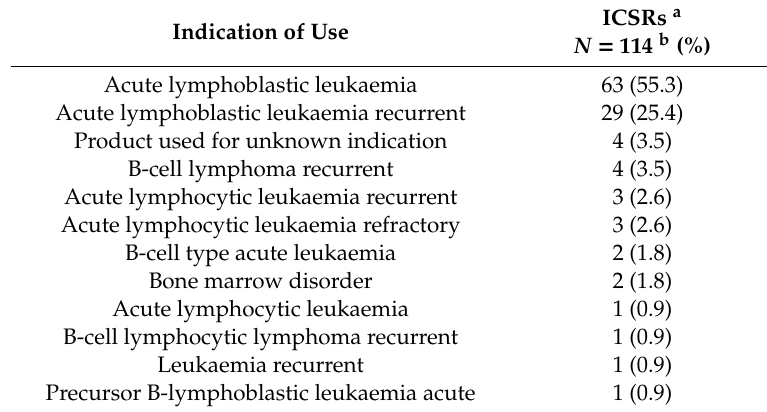
Table 2. Distribution of therapeutic indications as reported in tisagenlecleucel paediatric Individual Case Safety